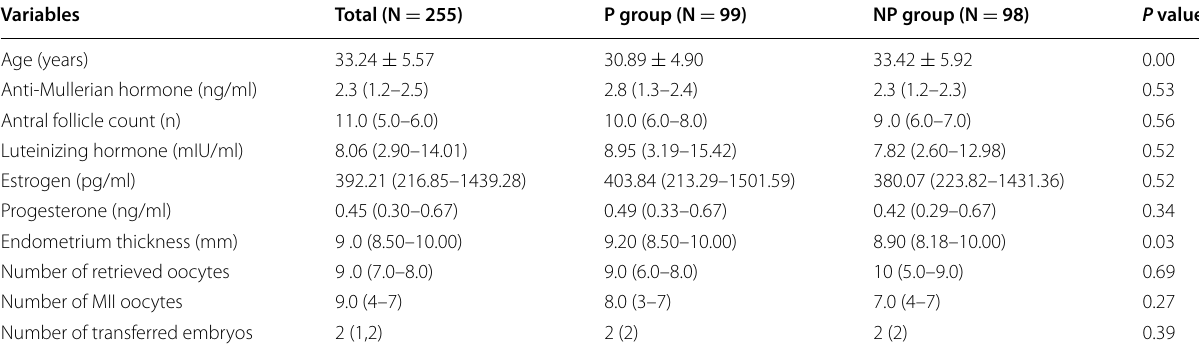
P pregnancy group, NP non-pregnancy group, p < 0.05 indicates significant difference between groups